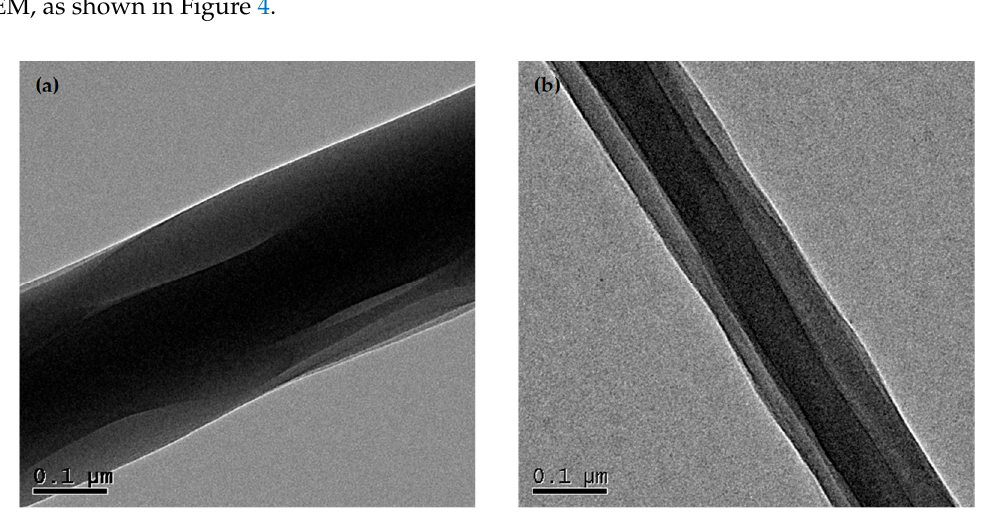
Figure 5. FTIR spectra of TPP ( a ); PEO ( b ); PLA ( c ); and core-shell fibers with the different weight ratios (DCM/DMF) (( d ) 9:1; ( e ) 7:3; ( f ) 5:5) at core solution flow rate of 0.2 mL/h.